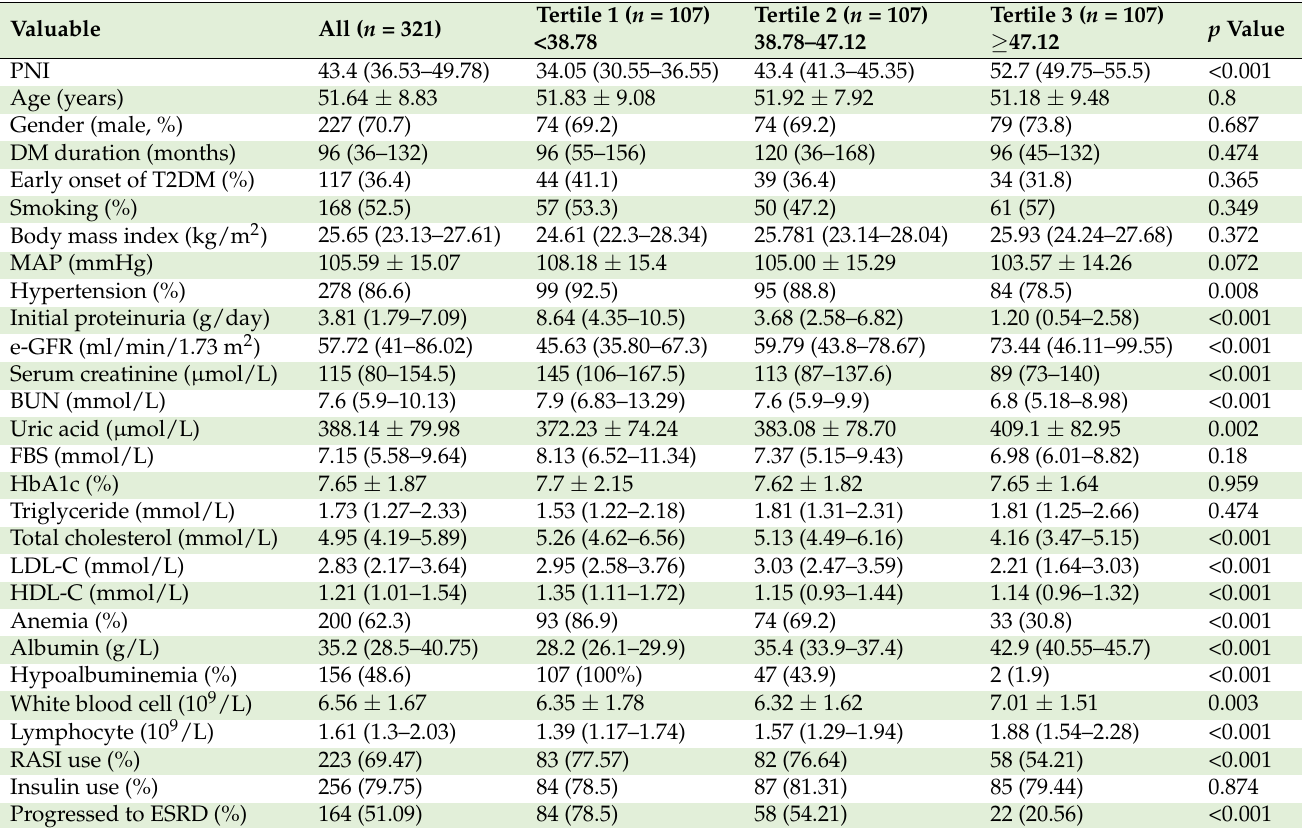
Table 1. Clinical features of the patients stratified across the tertiles of